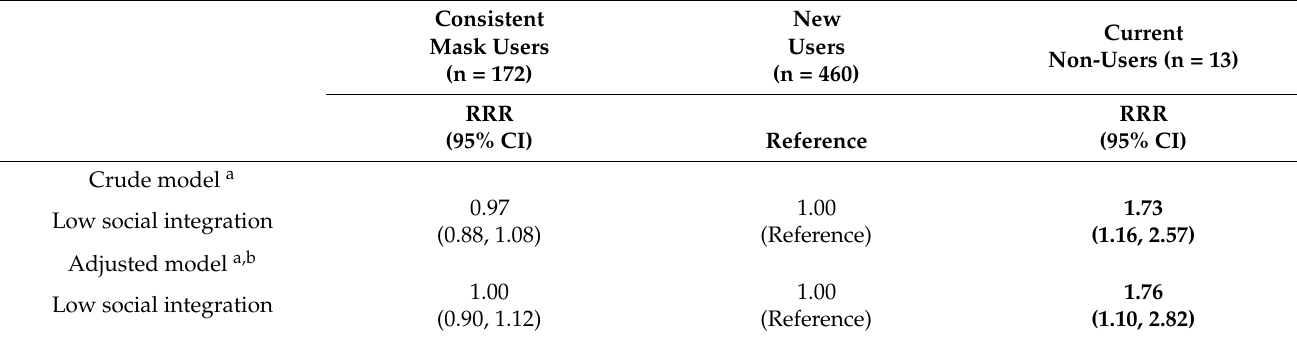
Table 8. Weighted associations between lower social integration and mask use behavior in the imputed dataset (n = 645).